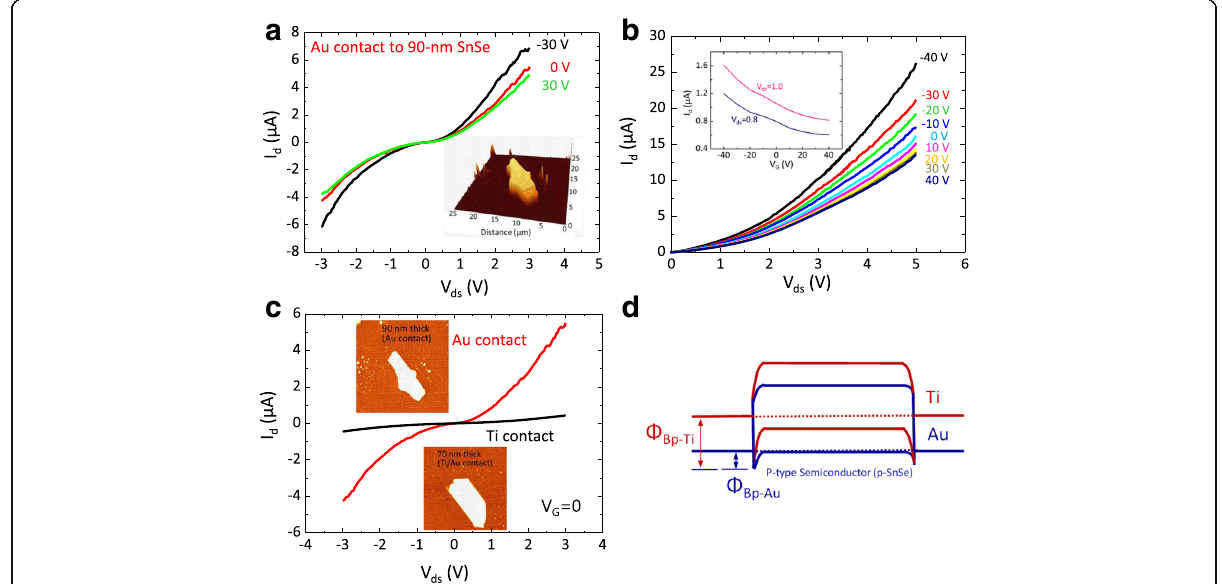
Fig. 4 a Drain current ( I d ) as a function of applied source-drain voltage ( V ds ), for the gate voltages ( V g ) of − 30, 0, and 30 V, for a 90-nm-thick SnSe nanoflake FET, at room temperature. b I d vs. V ds for V g ranging from − 40 – 40 V in steps of 10 V, for the 90-nm-thick SnSe nanoflake FET. The inset shows I d vs. V g for V ds of 0.8 and 1.0 V, measured at room temperature. c I d vs. V ds without biasing V g (=0) for Au and Ti contacts on a SnSe nanoflake FET. The inset shows an AFM scanned image of SnSe nanoflakes. d Schematics of the energy band diagrams of two metals, Au and Ti, on p-type SnSe